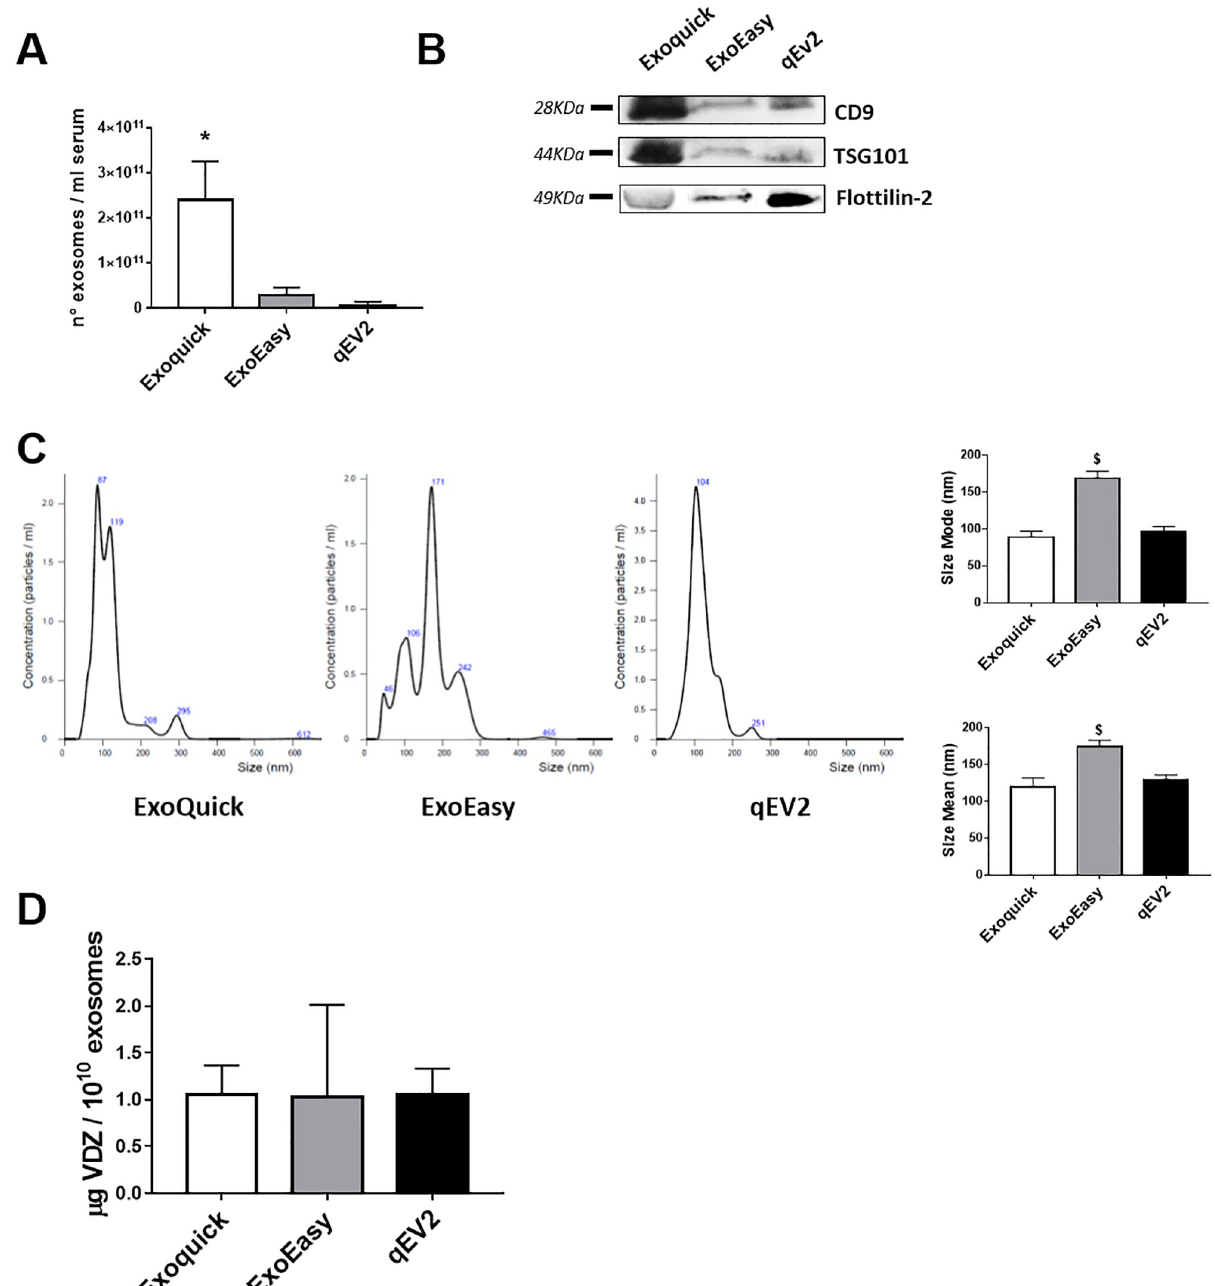
Fig 4. Comparison of three different methods of exosome isolation. Exosomes were isolated from a pool of patient’s sera by polymer precipitation (Exoquick), membrane-affinity (ExoEasy) and size-exclusion column (qEV2) methods. Vesicles were quantified by Exocet (A), validated for the expression of exosomal markers by immunoblotting (B) and analysed for size distribution by NTA (C). The levels of VDZ bound to exosomes were quantified by ELISA. Data are shown as mean ± SD. � p < 0.05 compared to exosomes isolated by ExoEasy and qEV2; § p < 0.05 compared to exosomes isolated by ExoQuick and